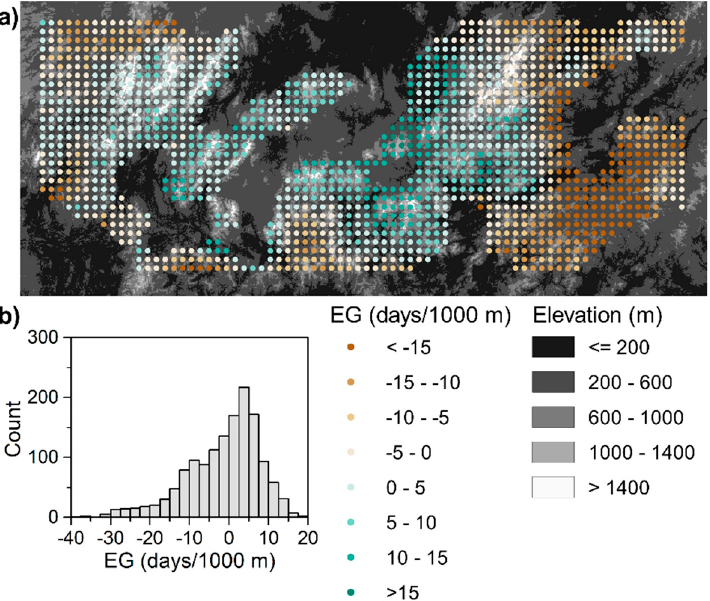
Figure 3. Elevation gradients (EG) of the multiyear mean SOS across the region. ( a ) Spatial pattern of the SOS elevation gradients. The points represent the centers of the spatial moving windows, and ( b ) the frequency distribution of the SOS elevation gradients.